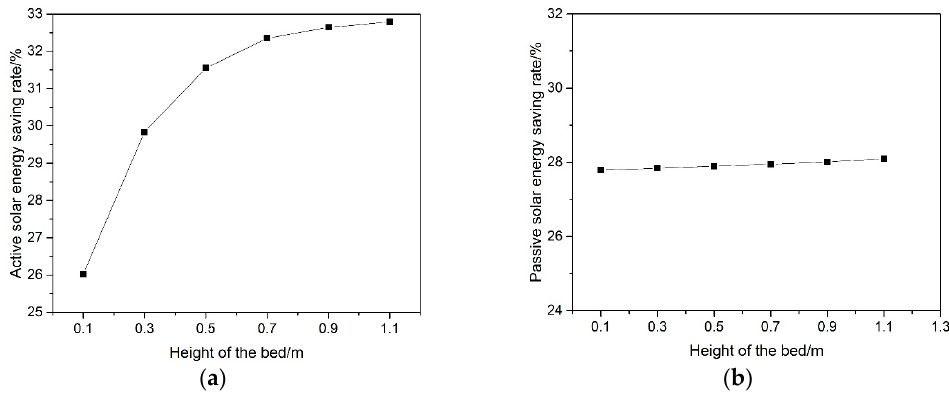
Figure 7. Influence of the bed height on solar residence energy saving rate on ( a ) Active solar energy saving rate; ( b ) Passive solar energy saving rate